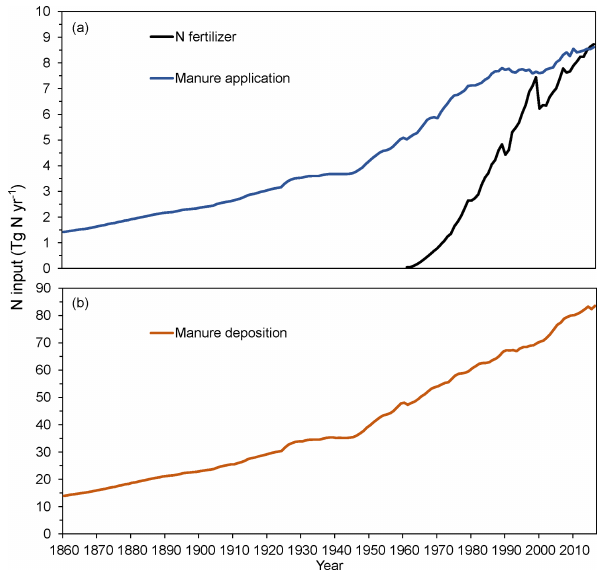
Figure 3. Temporal patterns of global manure N use, N fertilizer use and manure deposition in grassland systems: (a) manure N use and N fertilizer use on global pastures during 1860–2016 and dur- ing 1961–2016, respectively, and (b) manure N deposition to global pastures and rangelands during